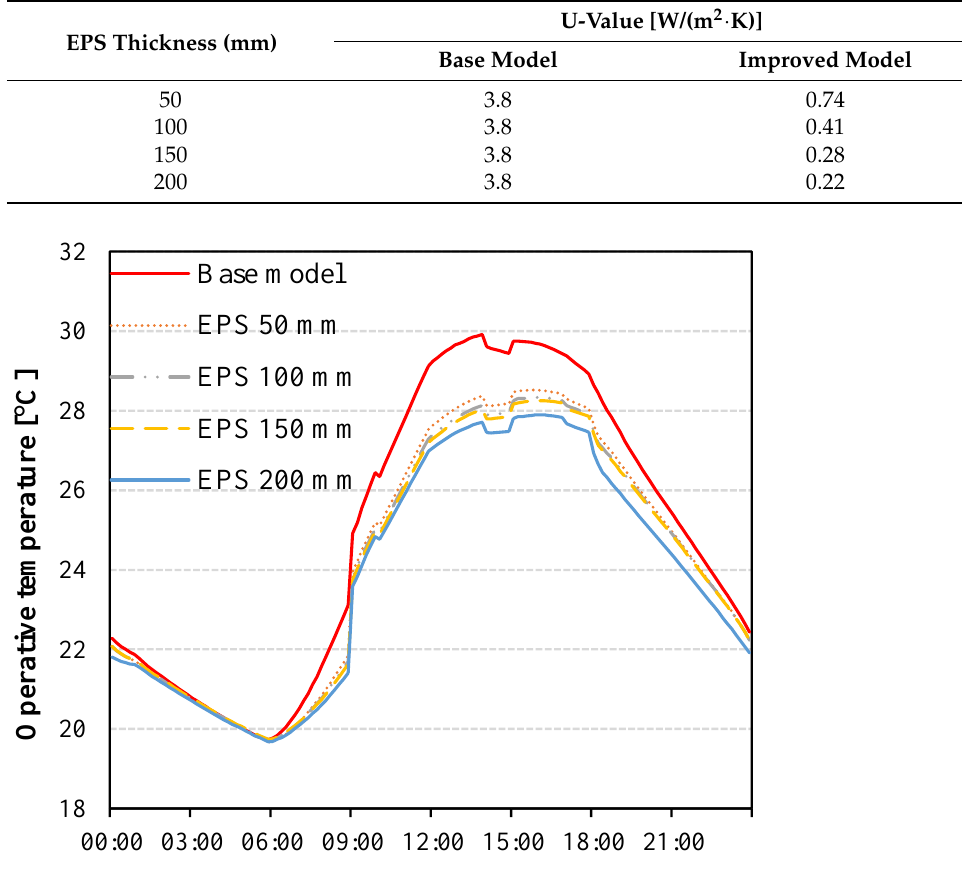
Table 10. Ceiling insulation fabricated of expanded polystyrene (EPS) and their thermal properties.